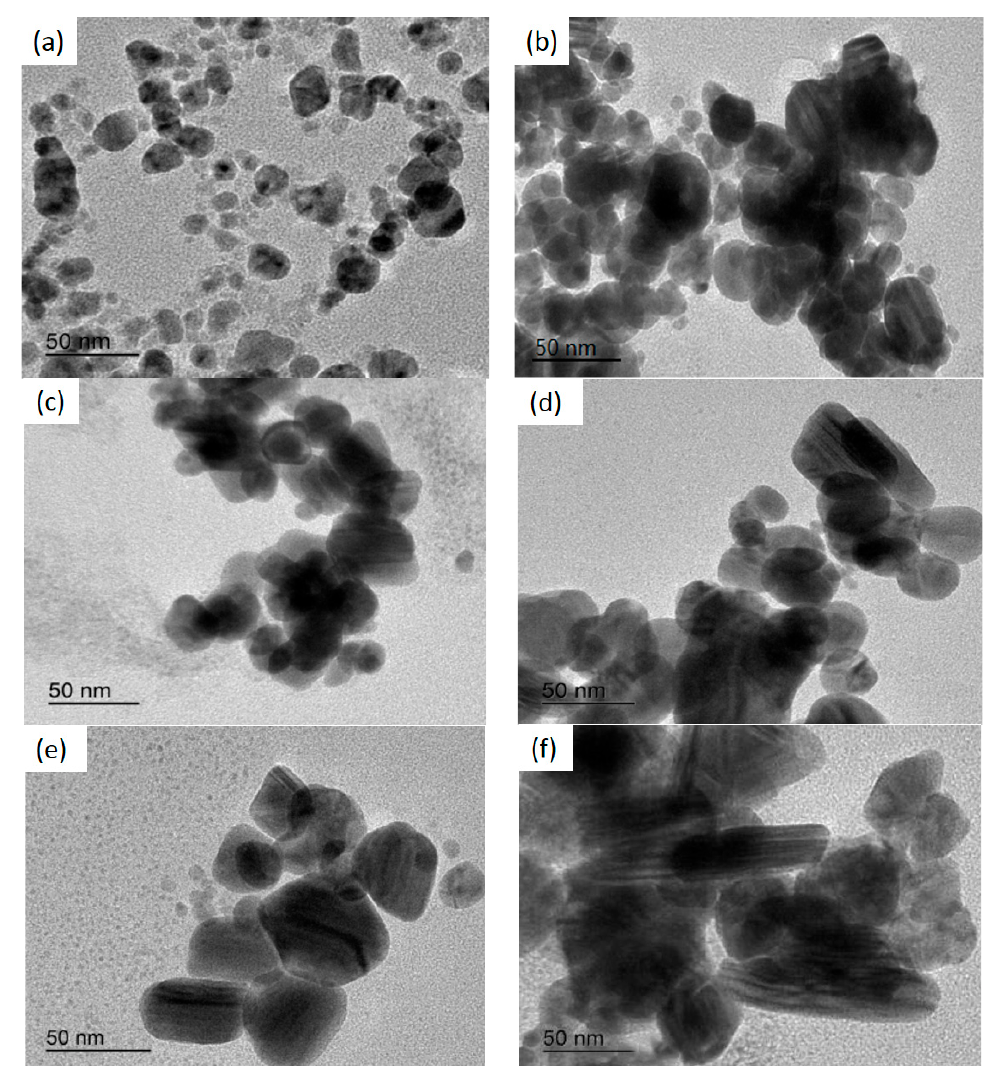
Figure 1. TEM observation of AgNPs synthesised using different concentrations of mango peel extract (( a ) 0.10 g/mL mango peel extract, ( b ) 0.15 g/mL mango peel extract, ( c ) 0.20 g/mL mango peel extract, ( d ) 0.25 g/mL mango peel extract, ( e ) 0.30 g/mL mango peel extract, ( f ) 0.35 g/mL mango peel extract).